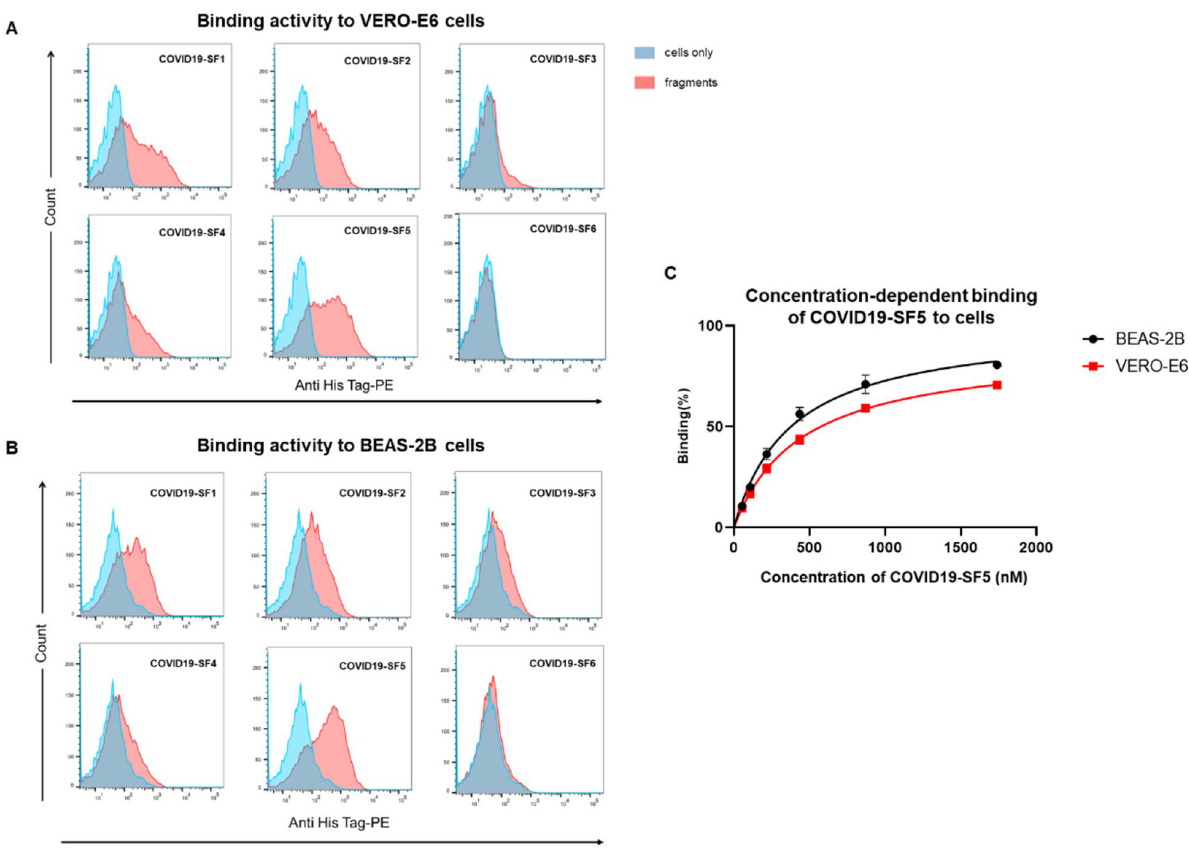
Figure 2. Flow cytometry and cell based-ELISA analysis of 6 fragments binding to VERO-E6 and BEAS-2B cells. ( A and B ) Flow cytometry was performed to assess the binding activity of 6 S protein fragments of SARS-CoV-2 to VERO-E6 cells and BEAS-2B cells. 0.25 μM His-tagged protein fragments (COVID19-SF1 ~ COVID19-SF6) were incubated with cells. The blue curves represent the cells only. The red curves represent COVID19-SF1-COVID19-SF6 binding. ( C ) Binding affinity of COVID19-SF5 to VERO-E6 and BEAS-2B cells were measured by cell based-ELISA. Cells were incubated with a series of concentrations of His-tagged COVID19-SF5 (0–40 μg/mL). The maximum binding was normalized to 100%. Mean value of 3 biological replicates mean ± SD (standard deviation) was shown. Data is a representative of 3 independent